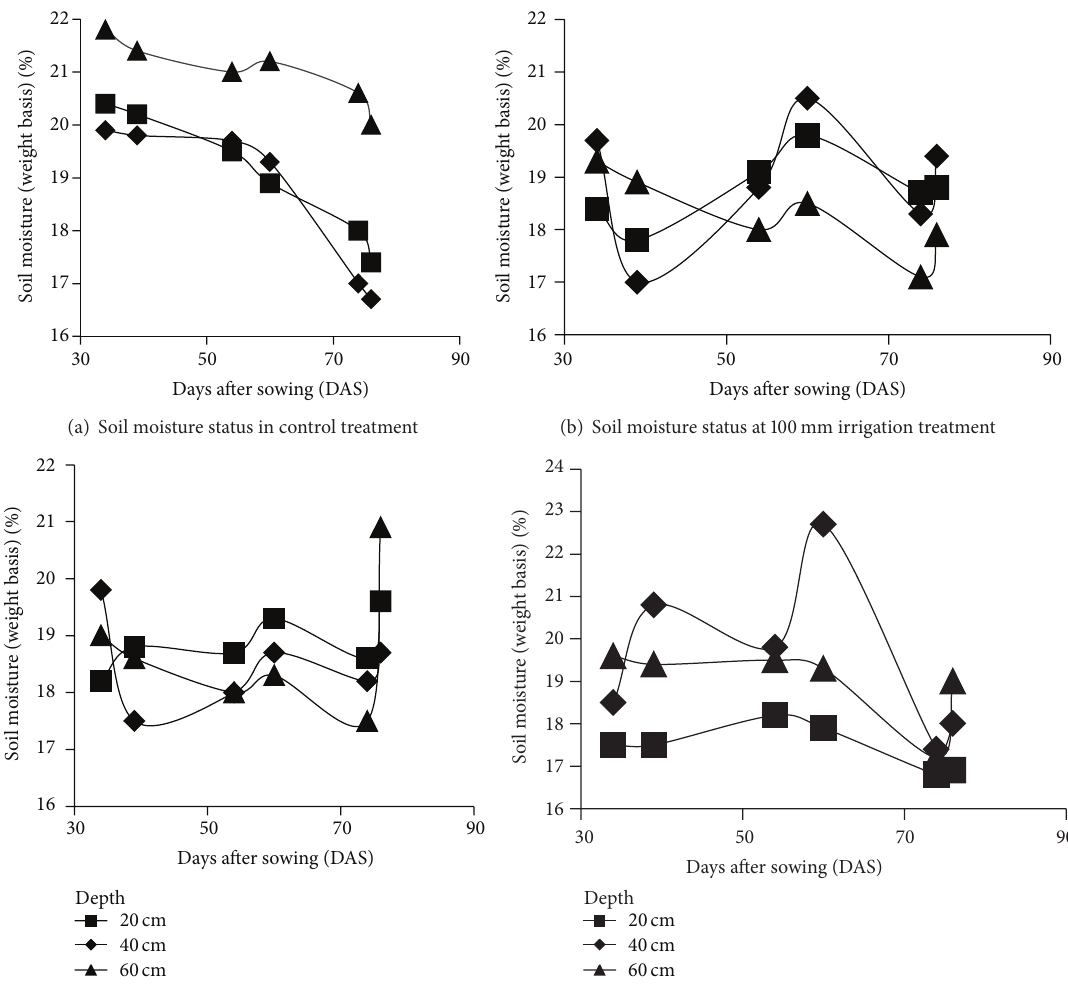
Figure 4: Soil moisture status at different depth of soil in irrigation